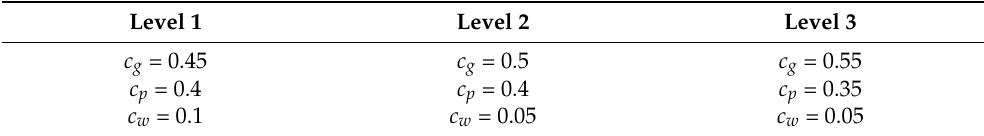
Table 9. Three levels of SSO parameter setting.